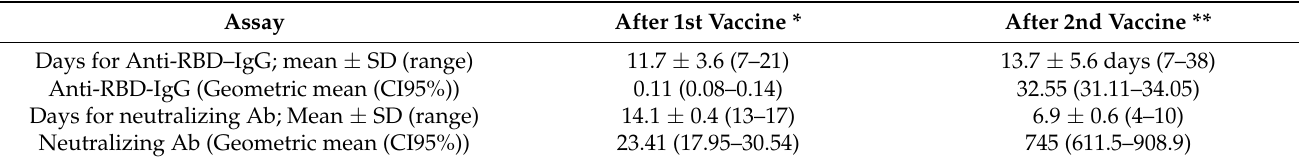
Table 3. Anti-RBD IgG and neutralizing antibodies titers following first and second vaccine. doses. Assay After 1st Vaccine * After 2nd Vaccine **